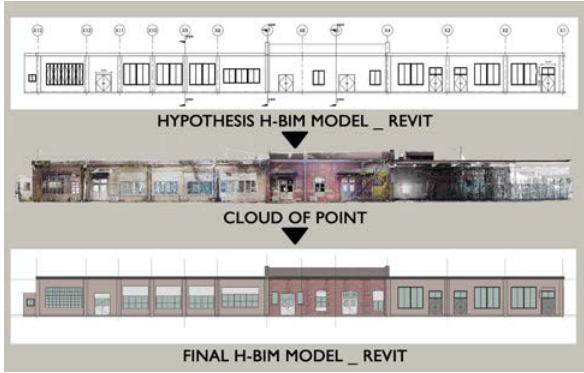
Figure 21: From hypothesized model to final